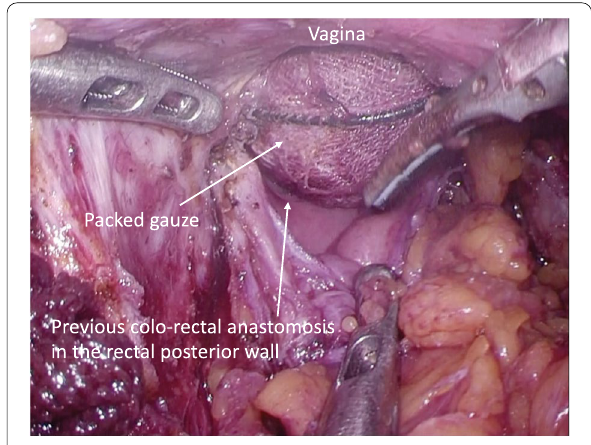
Fig. 4 While resectioning the rectum containing previous anastomosis, a moist gauze was packed in opened perineal space for maintaining pneumoperitoneum